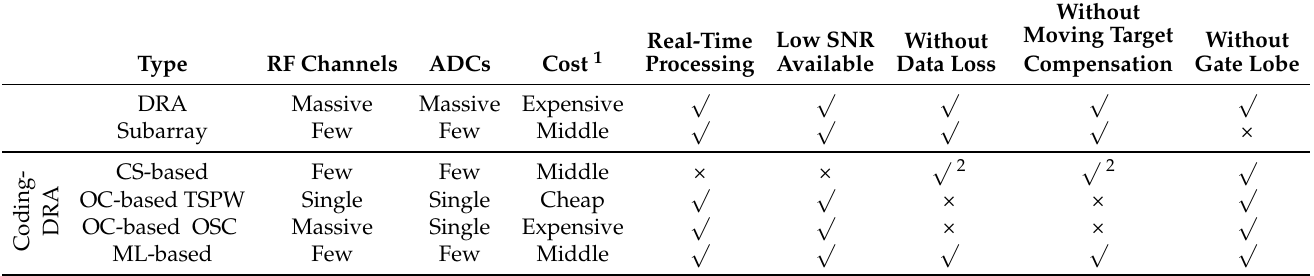
Table 1. Different architectures for low-cost DBF